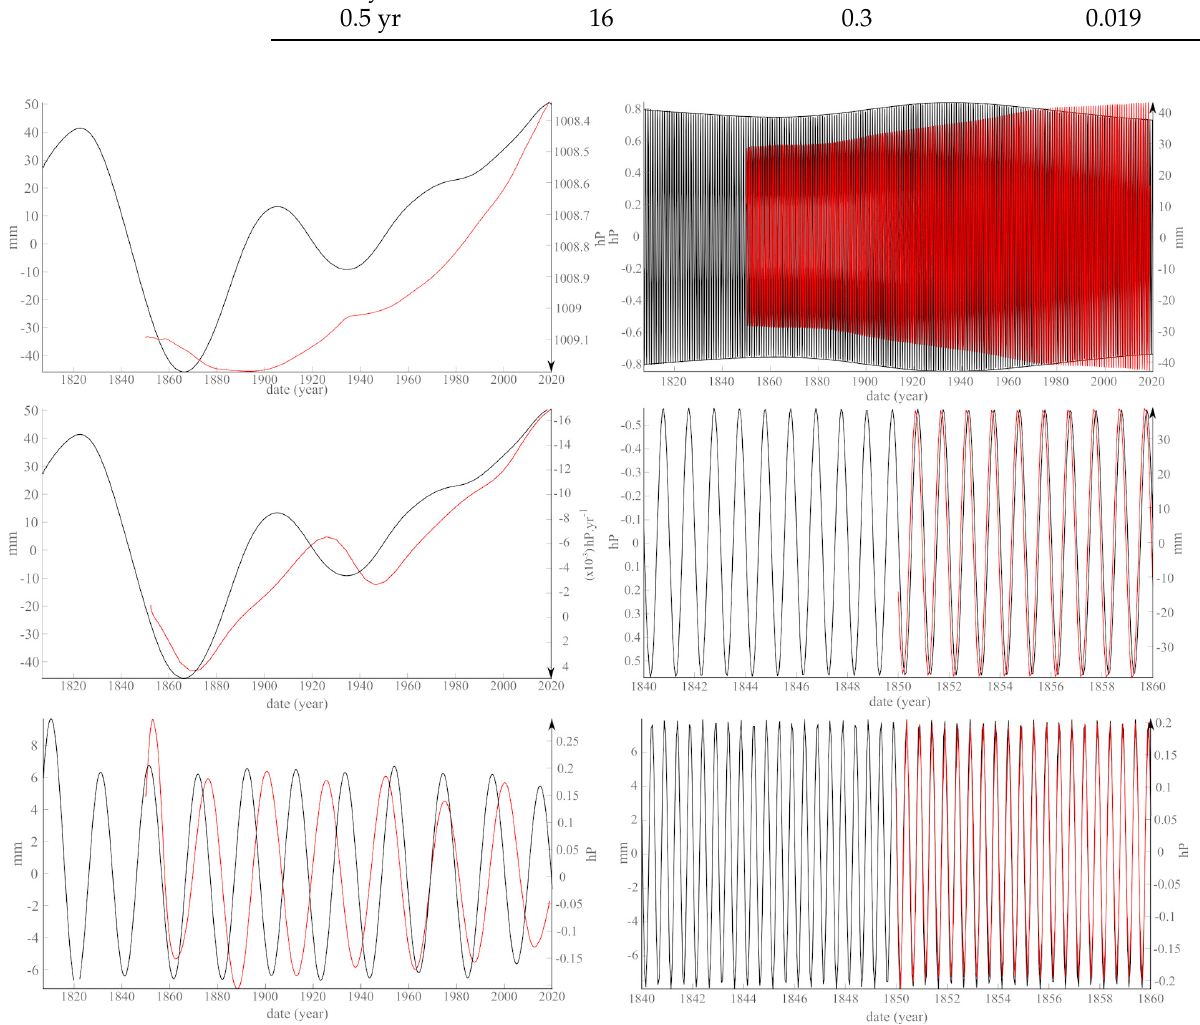
Figure 12. Top left , the superposition of the trends of GSLTG (in black) and GP (in red). Middle left , the superposition of the trend of GSLTG (in black) and the first derivative of the trend of GP (in red). Bottom left , the ∼ 20 yr components of GP (red) and GSLTG (black). Top right and middle right (a zoom), the annual oscillations of GSLTG (black) and GP (red). Bottom right , the semi-annual cycles of GP (red) and GSLTG